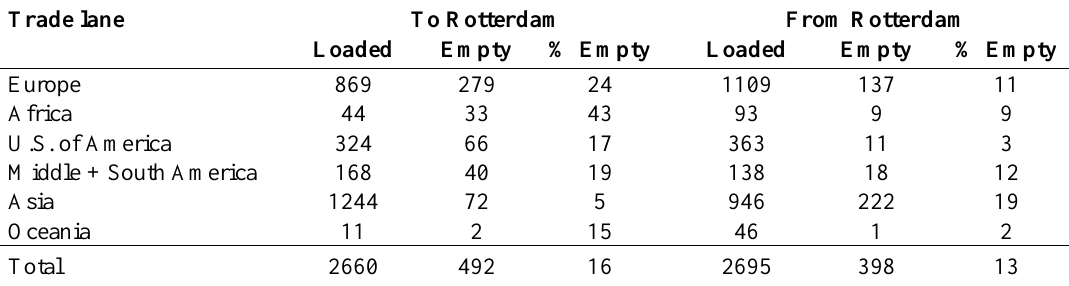
Table 1. Movements of containers per trade lane to/from Rotterdam (x 1000 TEU), 1999 Trade lane To Rotterdam From Rotterdam Loaded Empty % Empty Loaded Empty % Empty Europe Africa U.S. of America Middle + South America 168 Asia 1244 Oceania Total Source: Statistics